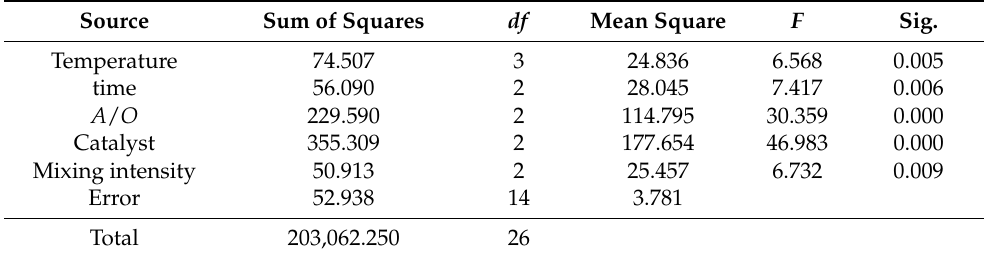
Table 4. Tests of between-subjects effects (dependent variable: BPY met). R 2 = 0.929 (adjusted R 2 =